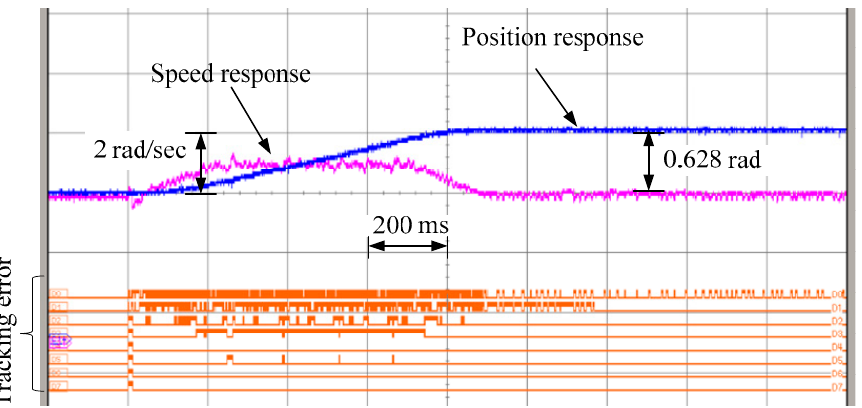
Figure 23. The position and speed responses with load.